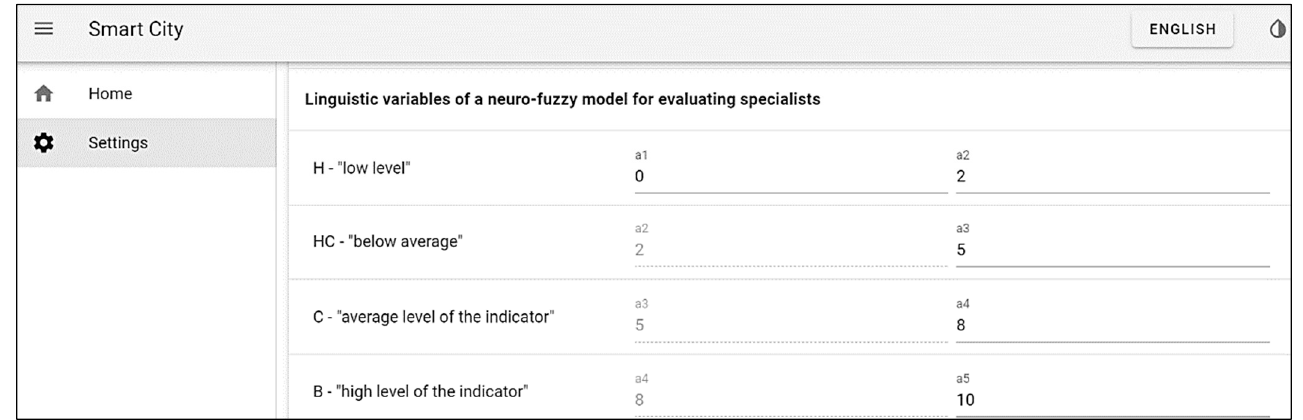
Figure 7. Smart City Concept Personnel Selection web platform setup screen.